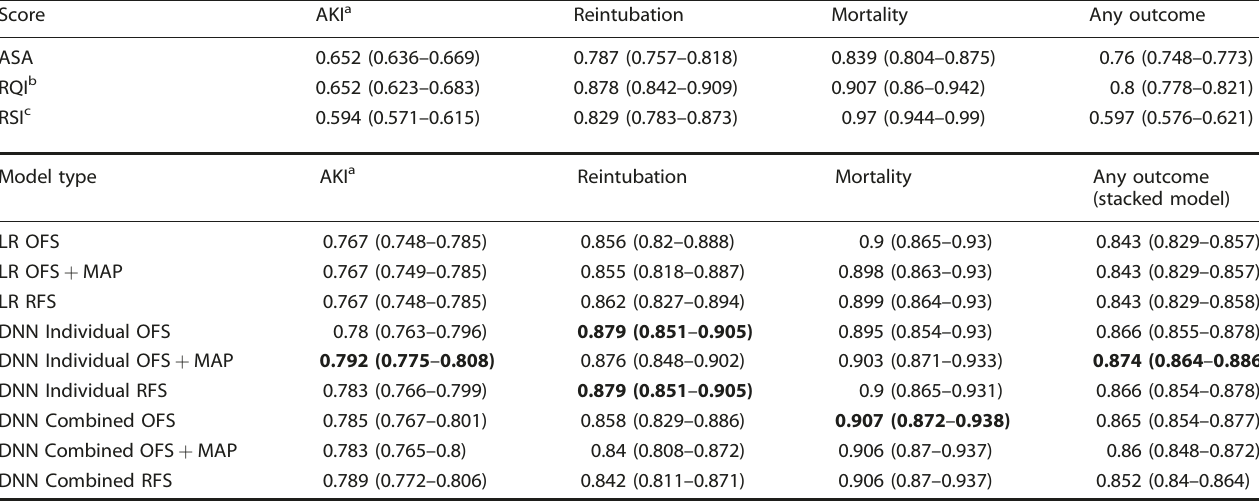
Table 2. AUC for prediction of acute kidney injury (AKI), reintubation, mortality, and any outcome with 95% CIs for the test set ( N = 11,996) for the ASA score, logistic regression (LR) models, deep neural networks predicting individual outcomes (DNN individual), and deep neural networks predicting all three outcomes (DNN